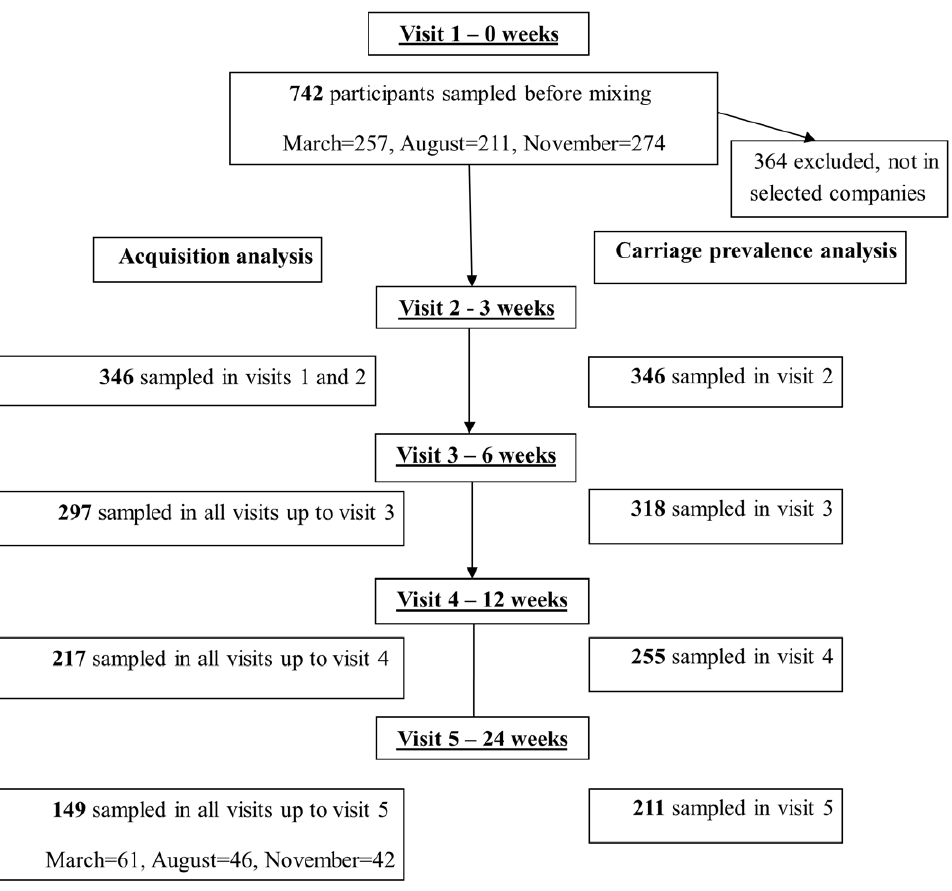
Figure 1. Flow chart of 742 participants in pneumococcal carriage study, for acquisition and for carriage prevalence analyses.